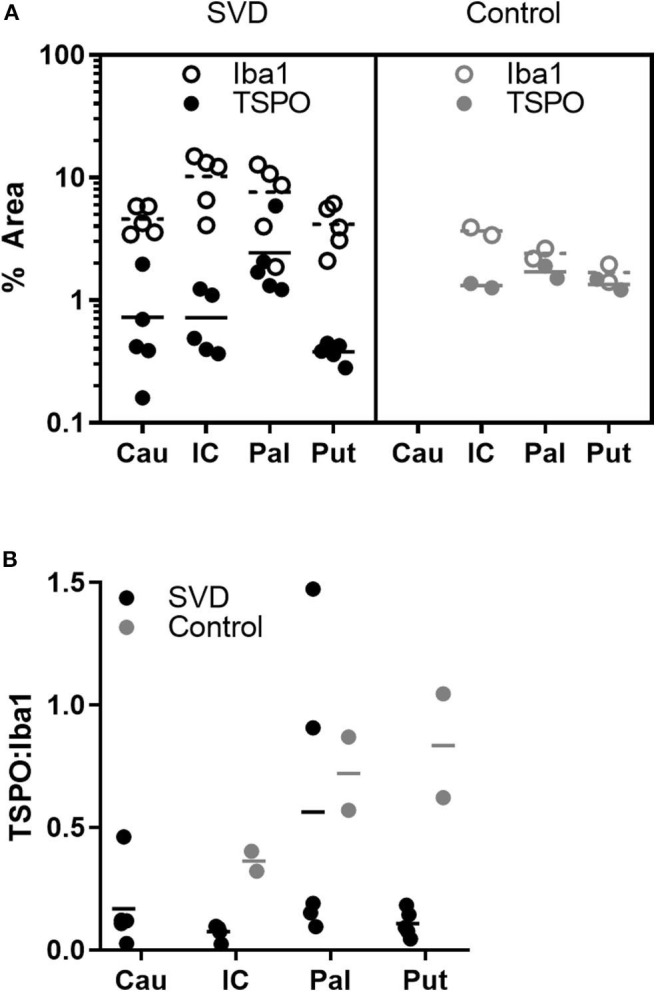
Fewer microglia express TSPO in SVD than control tissue. (A) Individual measurements of the pan-microglial marker Iba1 (hollow markers) and TSPO (filled markers) in SVD and healthy controls. In SVD, there are greater numbers of microglia but a smaller proportion express TSPO; (B) ratios of TSPO:Iba1 density in each group. The ratio is significantly lower in SVD over all regions. Horizontal line = mean.